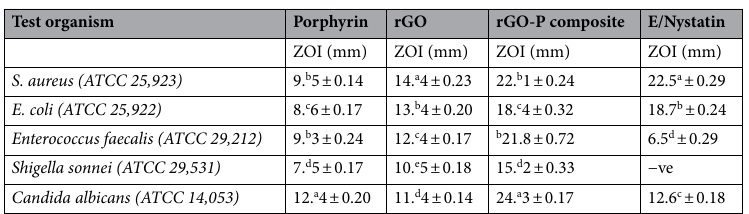
Table 2. Antimicrobial activity as the zone of inhibition ZOI (mm) of prepared samples against some pathogenic bacteria and yeast. *Values are means ± SD (n = 3). Data within the groups are analyzed utilizing one-way analysis of variance (ANOVA) accompanied by a, b, c, d, e Duncan’s multiple range test (DMRT). *rGO = reduced graphene oxide and rGO-P = reduced graphene oxide loaded porphyrin, −ve = no ZOI had been measured, E = Erythromycin; 20 μg/ml antibacterial standard. Nystatin 10 μg/ml antifungal standard. LSD Least significant